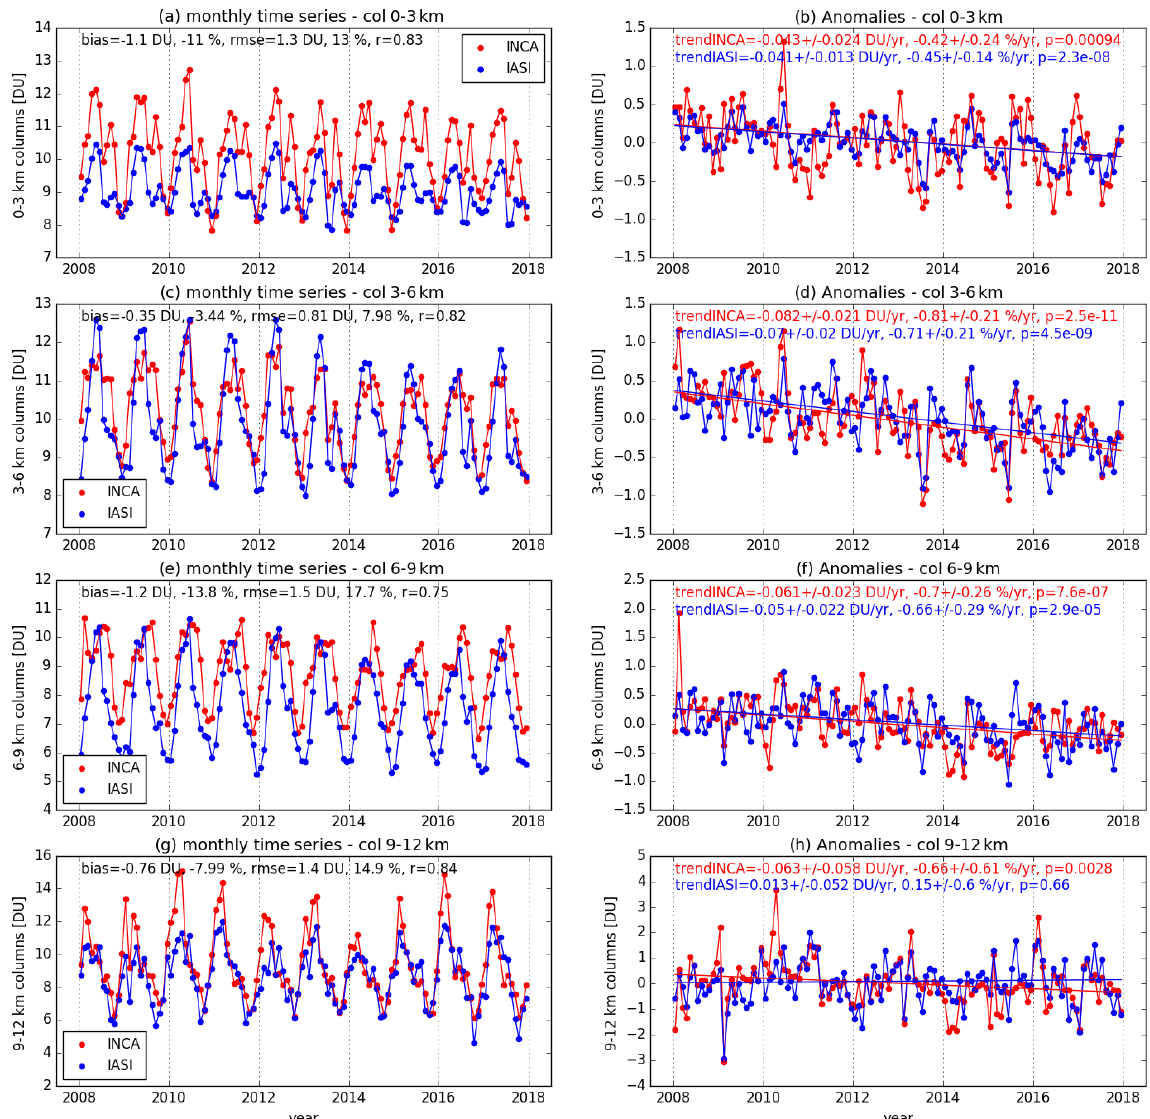
Figure 4. IASI and INCA monthly time series ( a , c , e , and g ) and anomalies ( b , d , f , and h ) for the 0–3, 3–6, 6–9, and 9–12km O 3 partial columns over the CEC region for 2008–2017. Biases, RMSE, and Pearson correlation coefficient between the IASI and INCA monthly time series are provided, as well as the trends, uncertainties, and associated p values calculated from the anomalies time